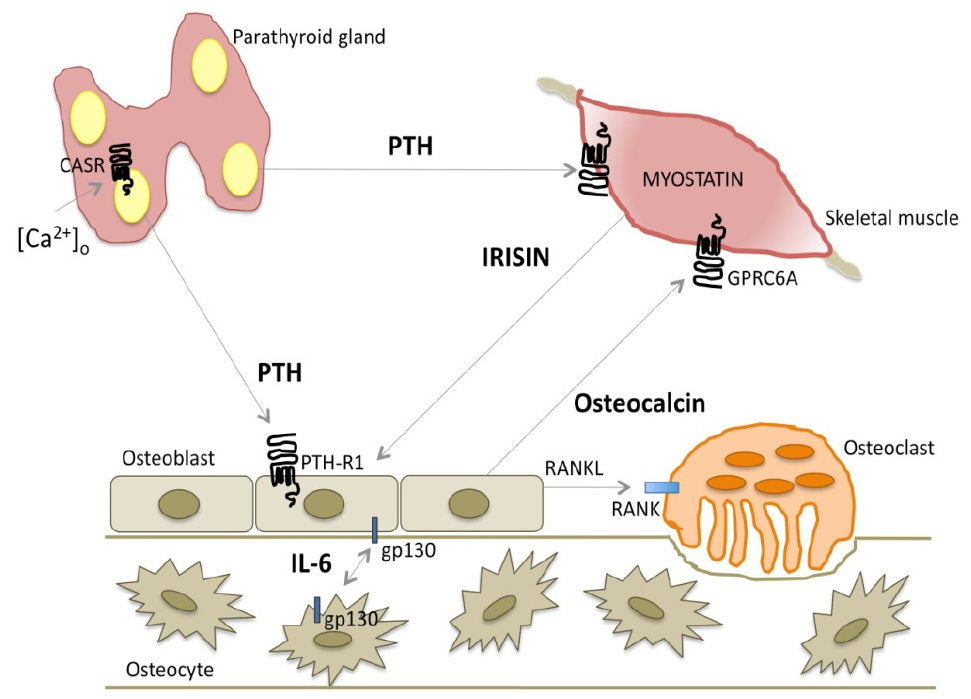
Figure 3. Crosstalk between parathyroid glands, bone, and skeletal muscle. The figure schematically